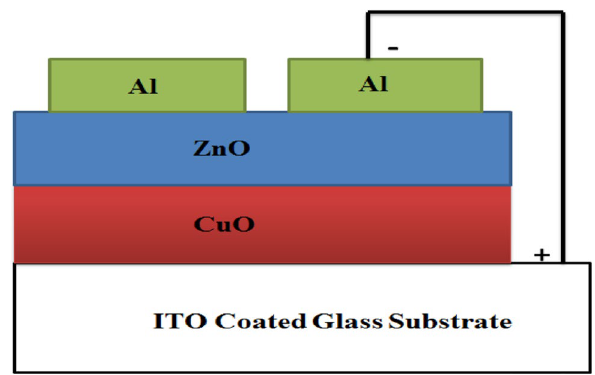
Fig. 1 Schematic representation of the bilayer-structured